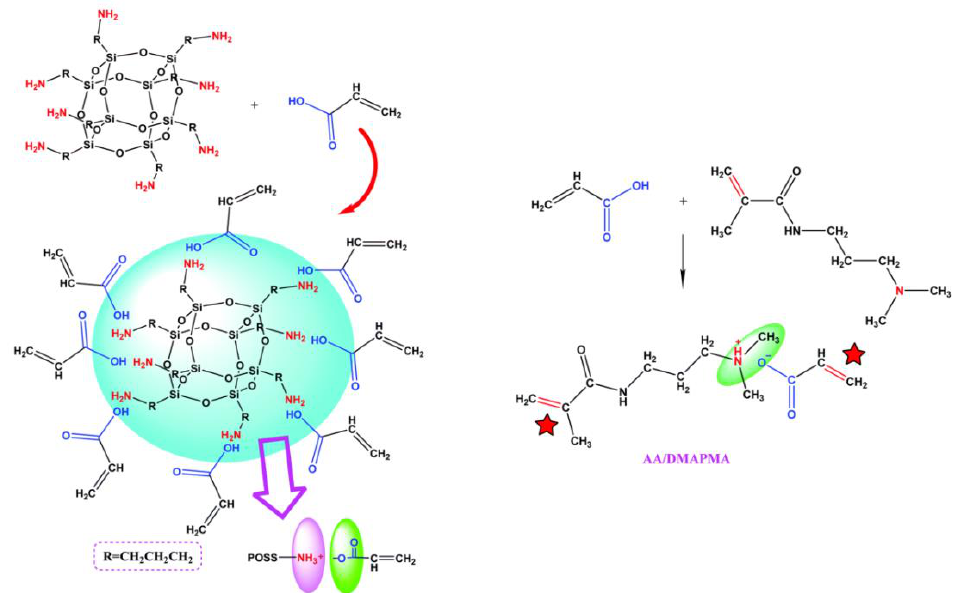
Figure 36. Synthesis of a hydrogel based on POSS–NH 2 –AA. Reproduced from Soft Matter 2017, 13 , 5645–5648 [106] with permission from the Royal Society of Chemistry.